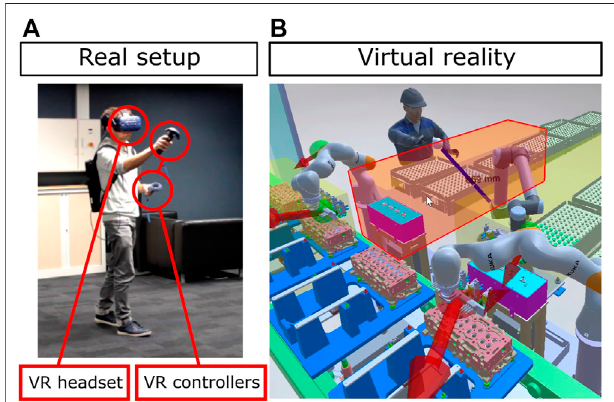
FIGURE 13 | An industrial use case involving two Kuka iiwa robots and oneUR10robot.Theuserisimmersed insidethedigitaltwinthankstoavirtual reality headset (A) . The simulation computes the robot velocities and kinetic energies, safety area intrusions and the minimum distance between the user and the robots (B) .